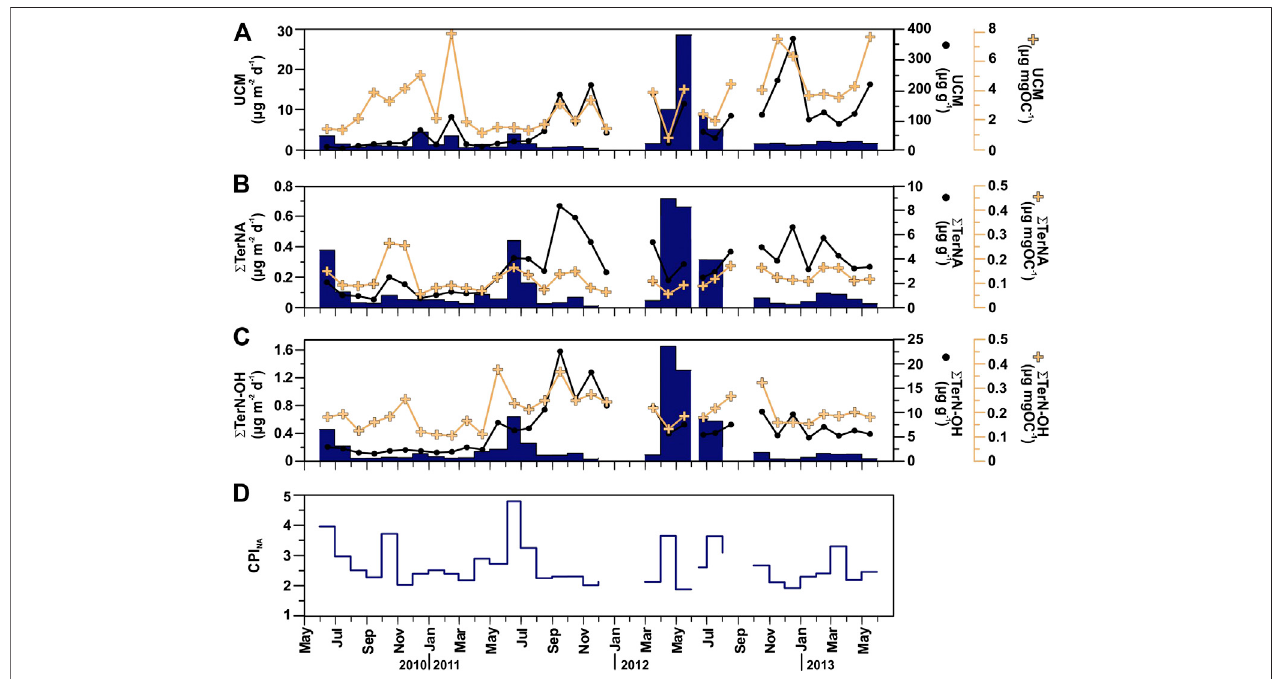
FIGURE7| Temporaldistributionpatterns( fl uxesandconcentrations)ofmajorterrestrialandanthropogenic-derivedPOCcompoundsinsinkingparticulatematter collected at 4,285 m in the Ierapetra Basin during the studied period: (A) Unresolved Complex Mixture of aliphatic hydrocarbons (UCM), (B) long-chain n- alkanes ( (cid:5) TerNa), and (C) long-chain n- alkanols ( (cid:5) TerN-OH), and (D) Carbon Preference Index of long-chain n- alkanes (CPI NA ) (see section “ Source Indicators of Sinking Particulate Organic Carbon ” for further details).